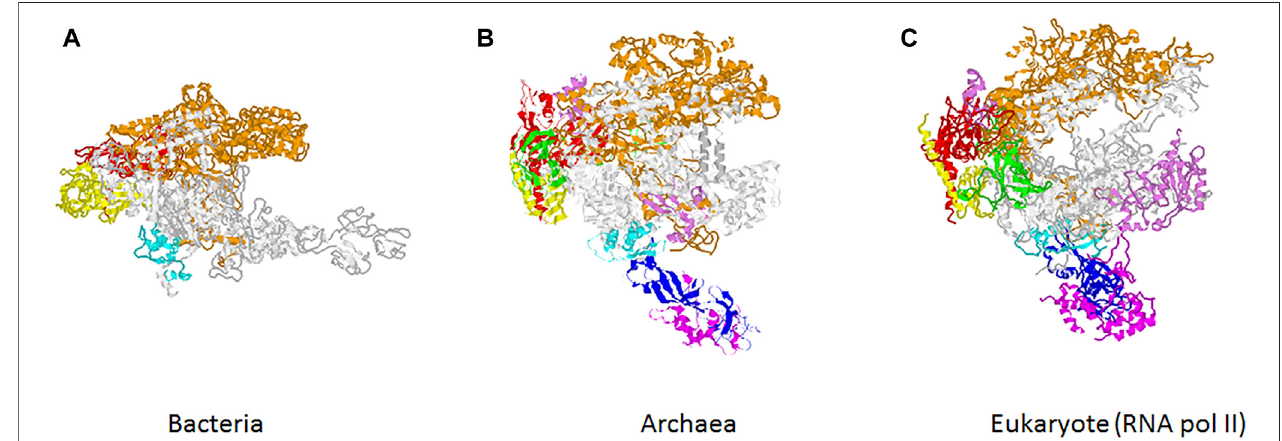
FIGURE 1 | Evolution ofRNA polymerases. Structure of RNA polymerase from bacteria (A) , archaea (B) and eukaryotic RNA pol II (C) . Color code corresponds to the previously used for Saccharomyces cerevisiae RNA pol II subunits (Armache et al., 2003). Similar colors are used for homologous subunits in bacterial and archaeal RNA